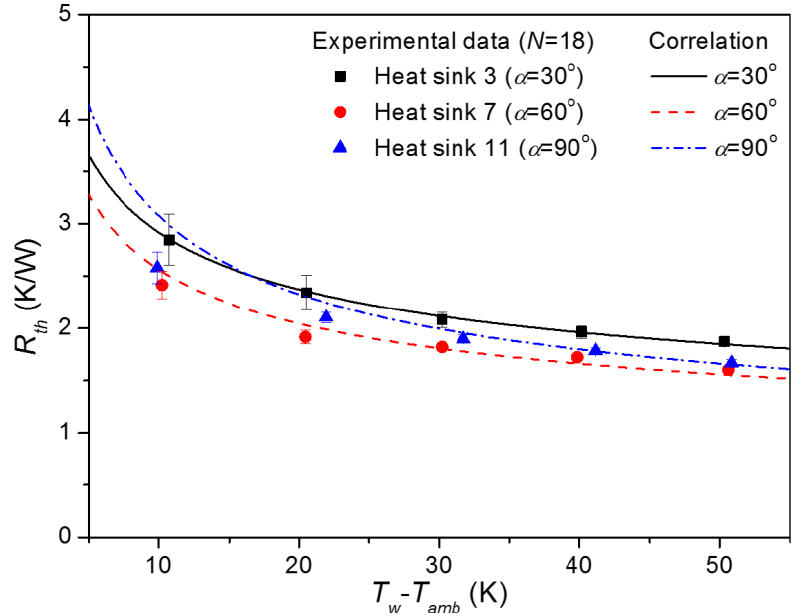
Figure 8. Thermal resistances for various inclination angles.